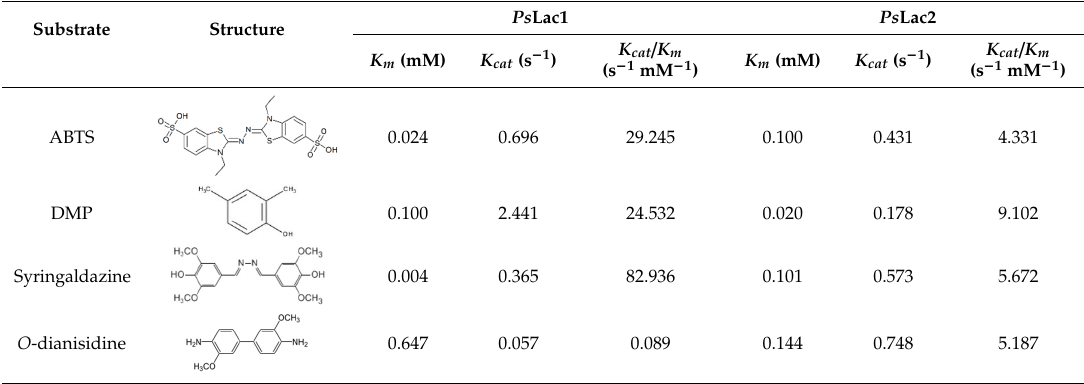
Table 2. Kinetic parameters of Ps Lac and Ps Lac2.